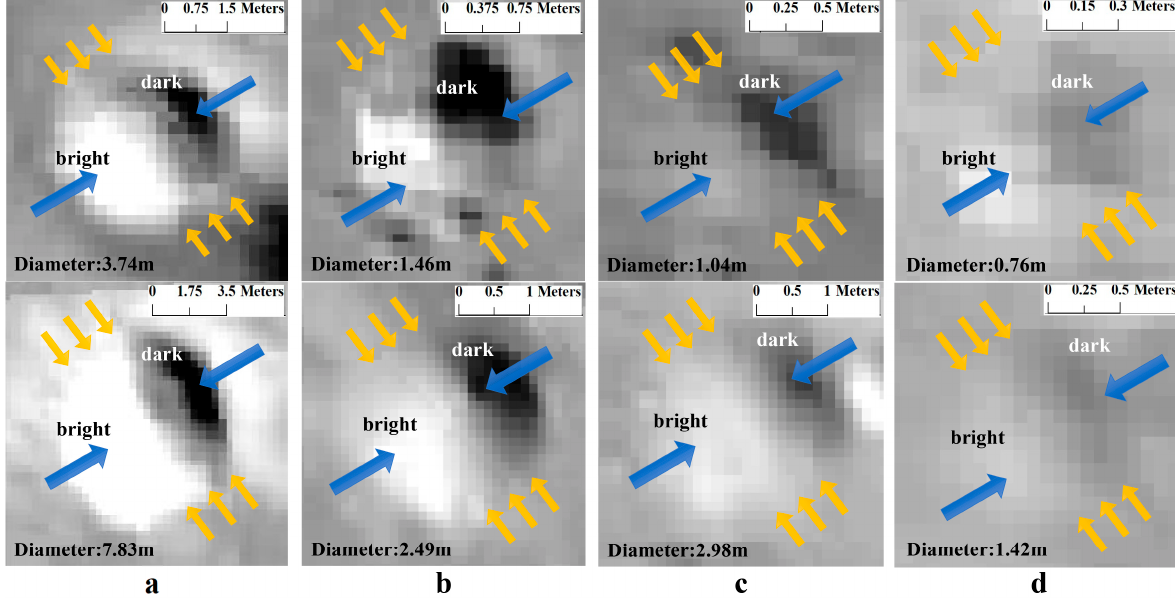
Figure 4. Examples of craters at four degradation levels, where ( a – d ) correspond to impact craters of types C1, C2, C3, and C4, respectively. Yellow arrows mark the impact crater boundaries. The diameters of the impact craters are written in the figures.